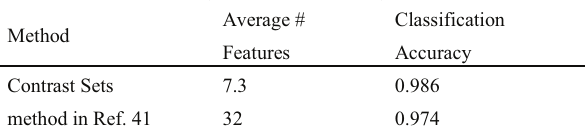
Table 8. Comparison of the average classification accuracy between DisCoSet and the method by Junejo and Al Aghbari. 41